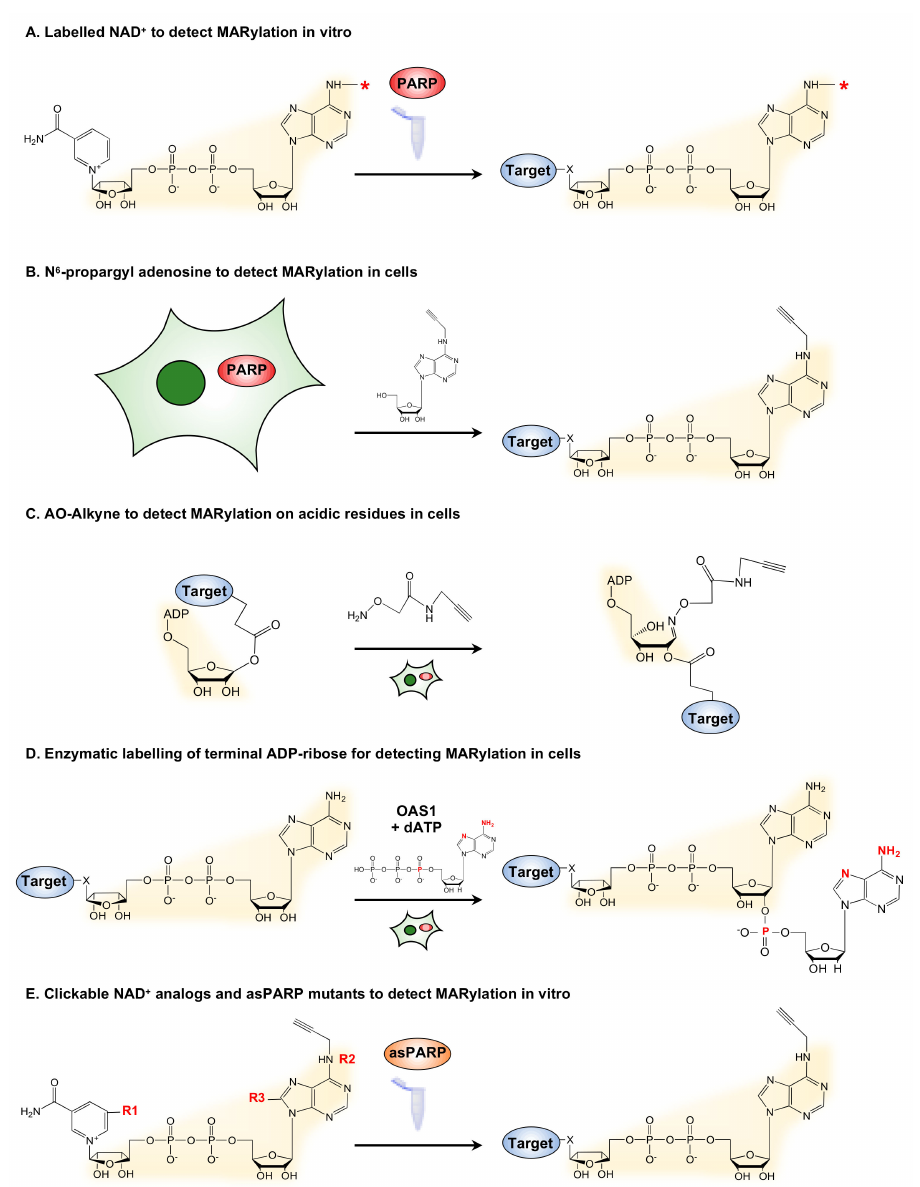
Figure 2. Strategies for the detection of mono(ADP-ribosyl)ation (MARylation). ( A ) Detection of in vitro MARylation using labeled nicotinamide adenine dinucleotide (NAD + ). PARPs utilize fluorescently or radioactively labeled NAD + to modify protein substrates that can then be detected by incorporation of the label. The asterisk (*) indicates a common site used for labelling. ( B ) N 6 -propargyl adenosine (N 6 pA) can be used to detect MARylation in cells. Metabolic labelling of cells